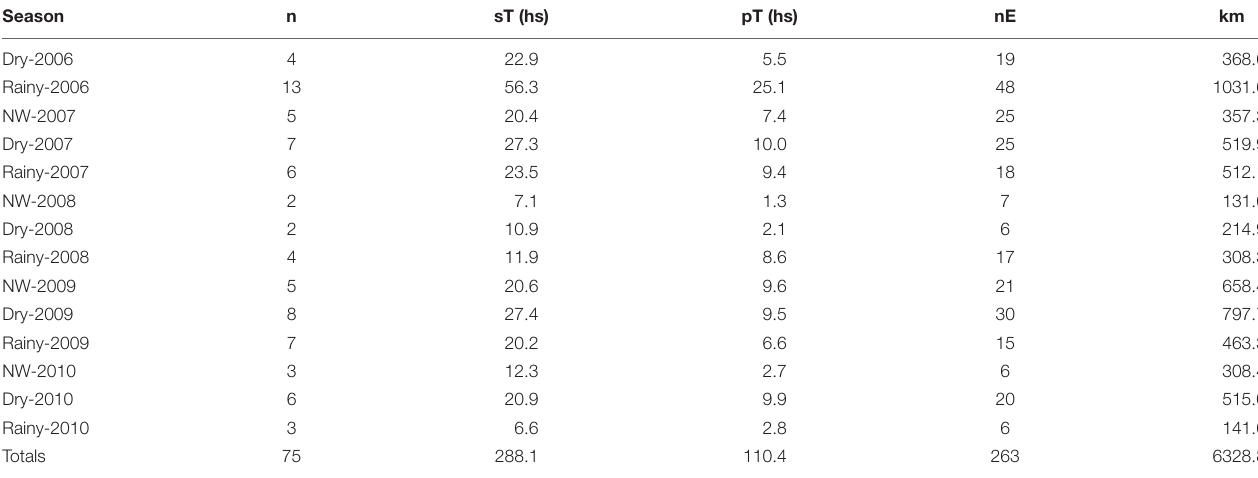
TABLE 1 | Summary of survey and photo-identification effort of bottlenose dolphins off Alvarado Veracruz System, south-western Gulf of Mexico. Season n sT (hs) pT (hs)